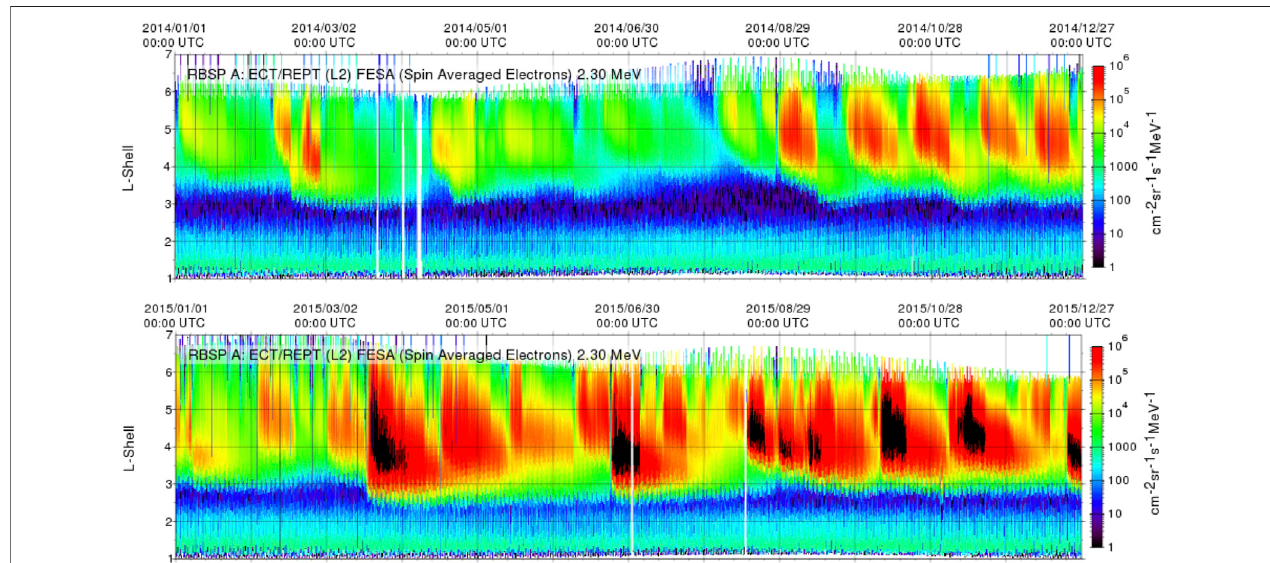
FIGURE 6 | The averaged radiation belt 2.3 MeV electron fl uxes from Van Allen Probe satellites in the period 2014 – 2015. The L-shell, which corresponds to distance from the Earth, is plotted on the Y -axis. The X -axis shows the time. The spectrogram shows that there are clusters of intense fl uxes, which corresponds to enhanced activity